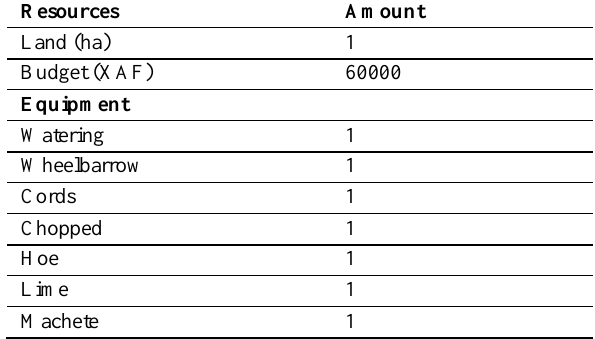
Table 11. Available resources in Scenario 1